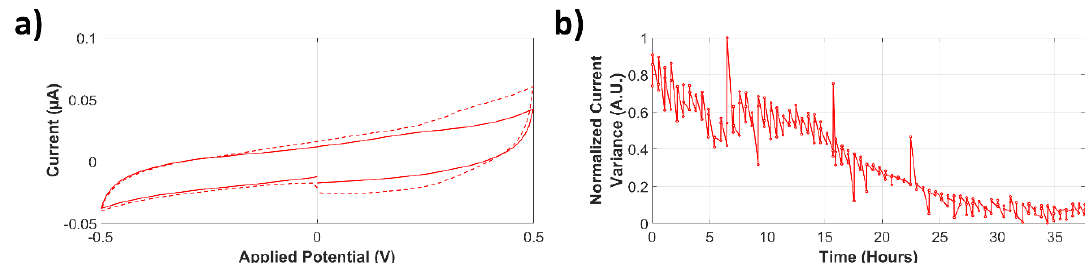
Figure 8. Analysis of current variance of a control experiment. ( a ) Cyclic voltammetry (CV) response of a control experiment. The dashed line represents the mean CV response during the first ~23 h. The solid line represents the mean CV current response during the following ~15 h. ( b ) Normalized current variance for a ~37-h experiment.